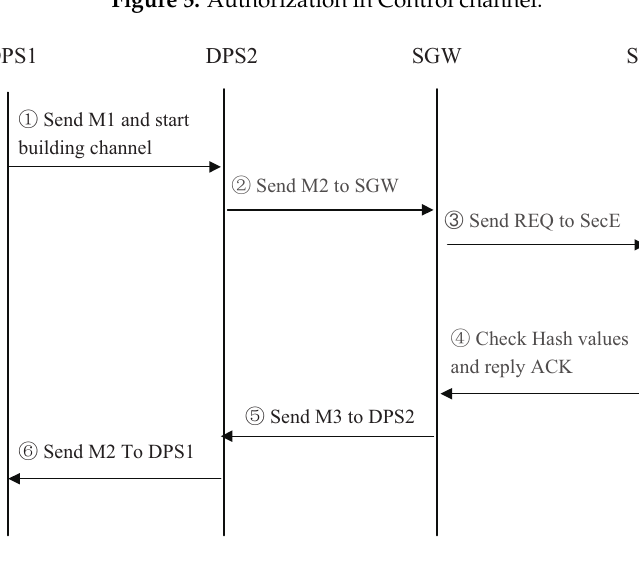
Figure 5. Authorization in Control channel.